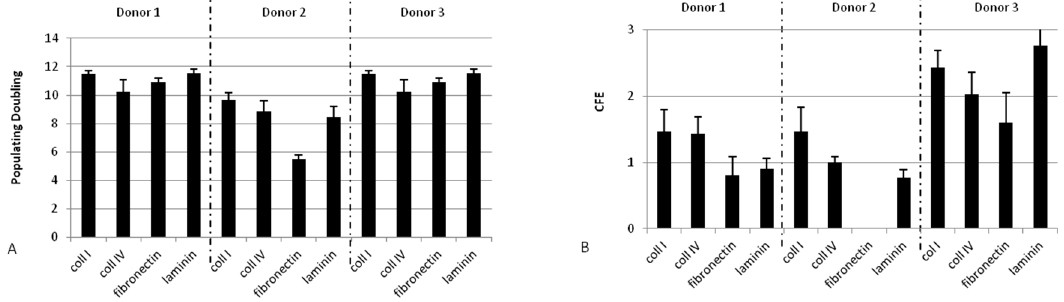
Figure A1. Influence of adhesion support on clonogenic and proliferative potential of obtained cellular suspension (RA and LA) obtained from a model 2 assay ( A ). Population doubling obtained after detachment of cells having adhered for 10 min to different supports; ( B ) CFE obtained after detachment of cells having adhered for 10 min to different supports. Collagen I presents the most positive and homogenous difference between RA and LA cells for the number of total colonies as well as for holoclone colonies and population doubling for the three donors studied. Results for three donors are separated by the dotted line.